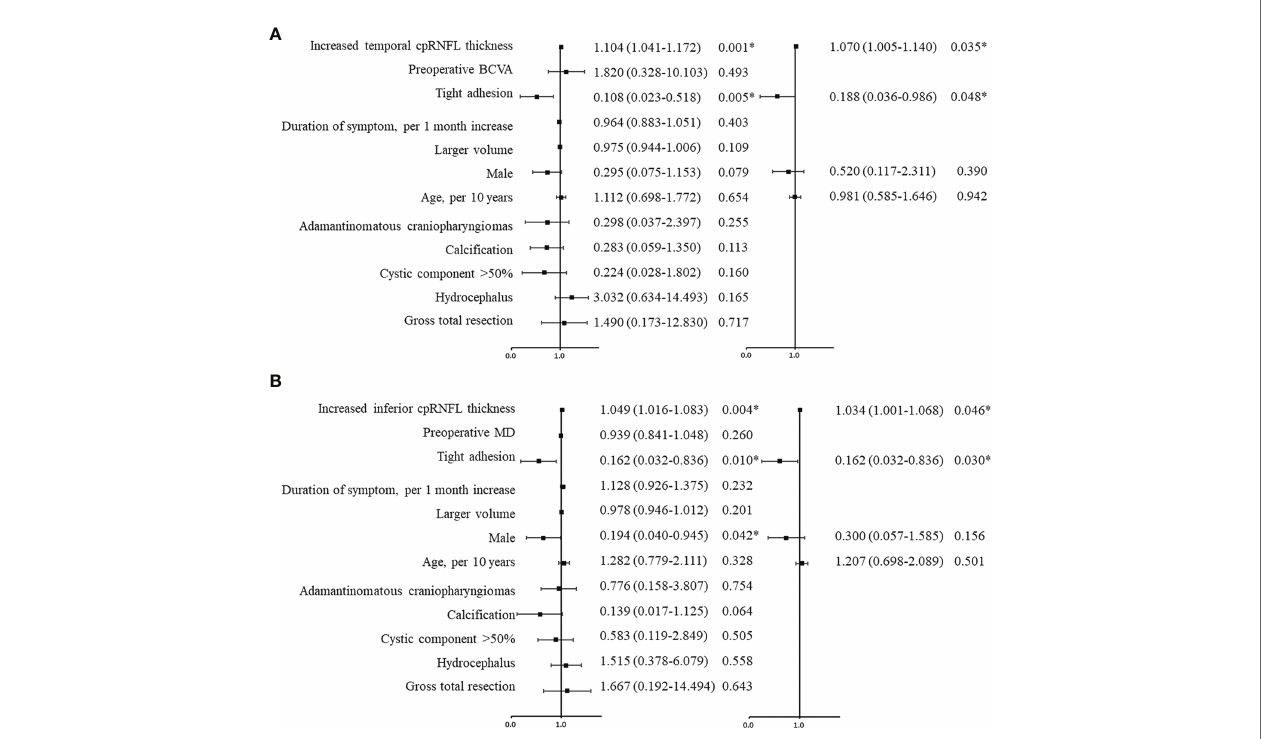
FIGURE 3 | Univariate and multivariate logistic regression analyses were used to evaluate the predictive factors for visual prognosis following surgery for craniopharyngiomas. The black squares indicate the OR values, error bars represent 95% CIs, and *p < 0.05. According to the analysis, increased temporal (A) and inferior (B) cpRNFL were favorable factors for postoperative visual acuity and visual fi eld, respectively. Tight adhesion was an adverse factor for visual recovery. cpRNF, circumpapillary retinal nerve fi ber layer; BCVA, best corrected visual acuity; MD, mean deviation.